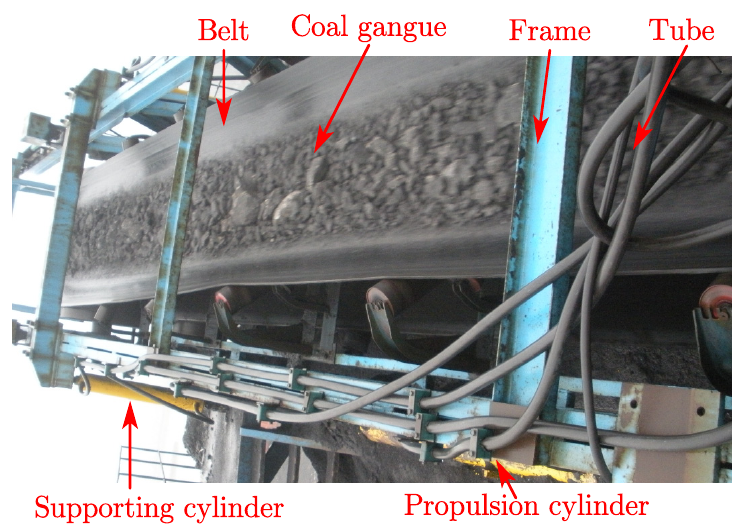
Figure 2. Coal gangue conveyor equipment.